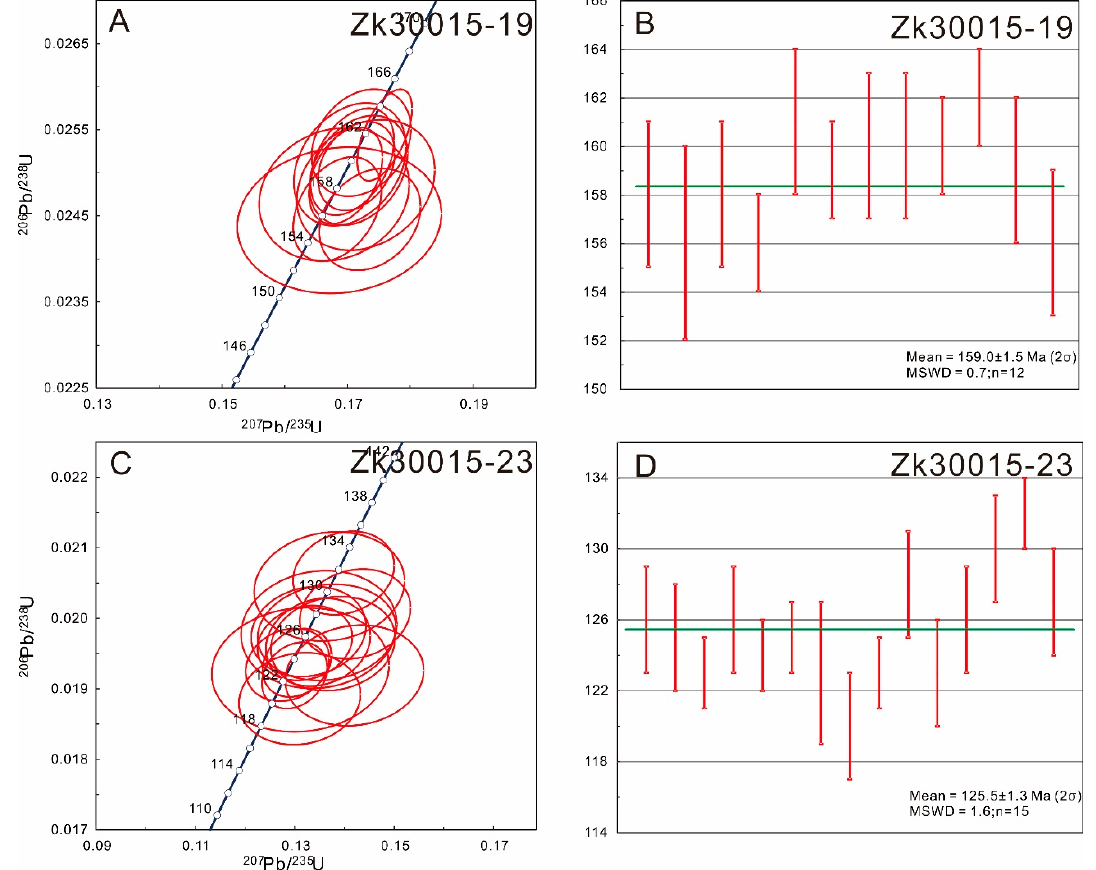
Figure 7. LA-ICP-MS zircon U–Pb concordia plots and weighted mean age diagrams for granites in the Maoping W–Sn deposit.